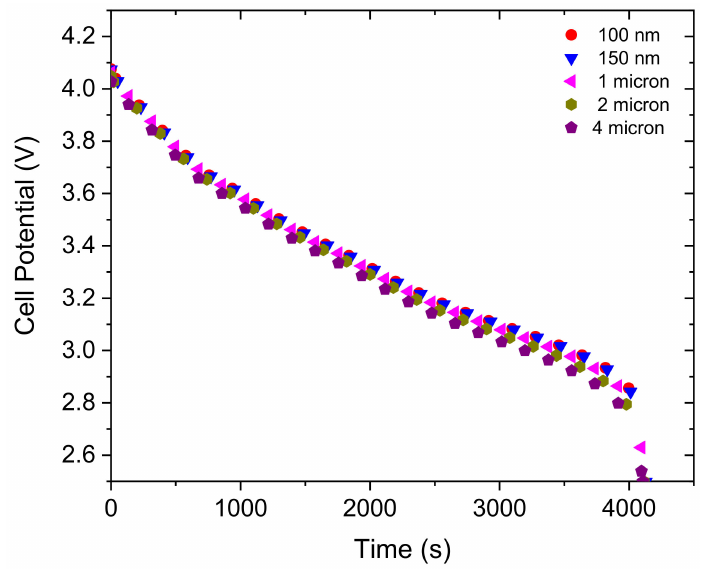
Figure 3. Simulated discharge curves for different Si anode particle sizes after the 2000th cycle. Further, the electrolyte volume fraction stability at both anode interfaces in Figure 4 was assessed at four different values of the volume fraction of the electrolyte in the anode material ( ε 1,e ) , 0.55, 0.50, 0.45 and 0.40, while holding the volume fraction of the electrolyte in the positive electrode constant at 0.41. The positive electrode volume fraction was based on the values from the COMSOL materials library.